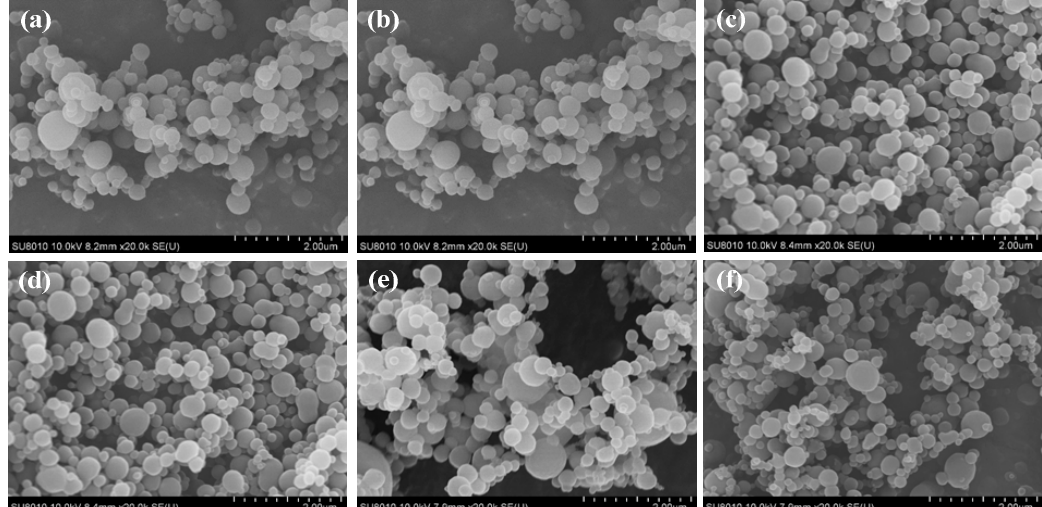
Figure 7. SEM images of the purified PBT particles at different conditions: ( a ) 25 °C, 7.6 MPa; ( b ) 25 °C, 7.6 MPa; ( c ) 25 °C, 8.3 MPa; ( d ) 25 °C, 9 MPa; ( e ) 27.5 °C, 8.3 MPa; and ( f ) 30 °C, 8.3 MPa.